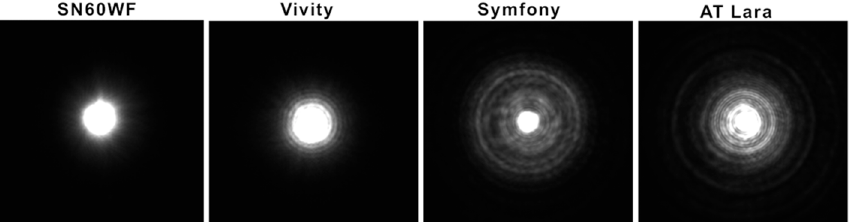
Figure 4. The PSF images present a visualization of the light distribution with a 0.1 mm pinhole for all IOLs tested. Both diffractive IOL models created an extended halo pattern. The Vivity showed minimally increased light spread compared to the monofocal SN60WF.